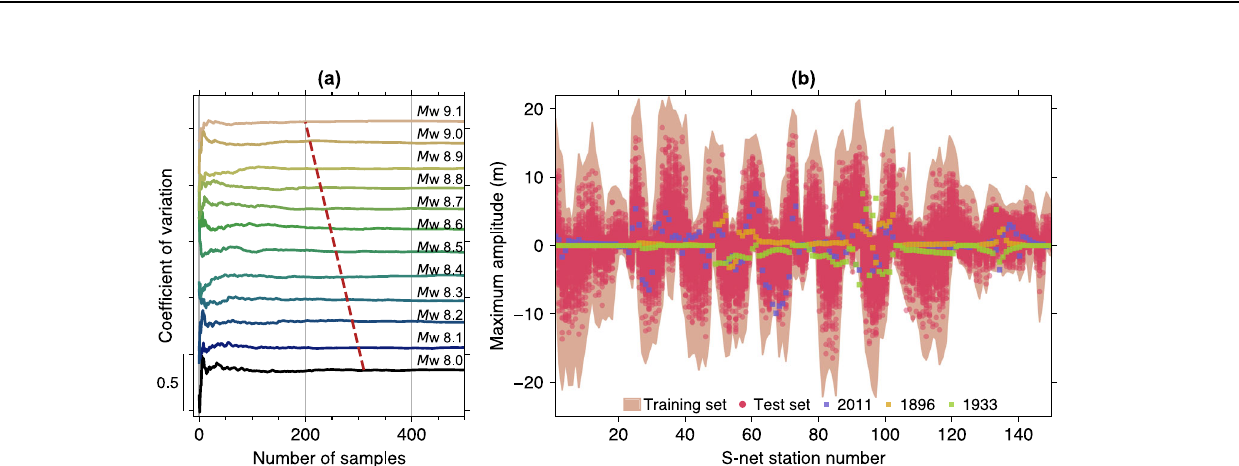
Fig. 2 | Hypothetical tsunami source scenarios. a Discretization of the Japan Trench plate interface and outer-rise faults (white rectangles). Dashed contours depict the slab depth 20 . b Examples of stochastically generated slip on the